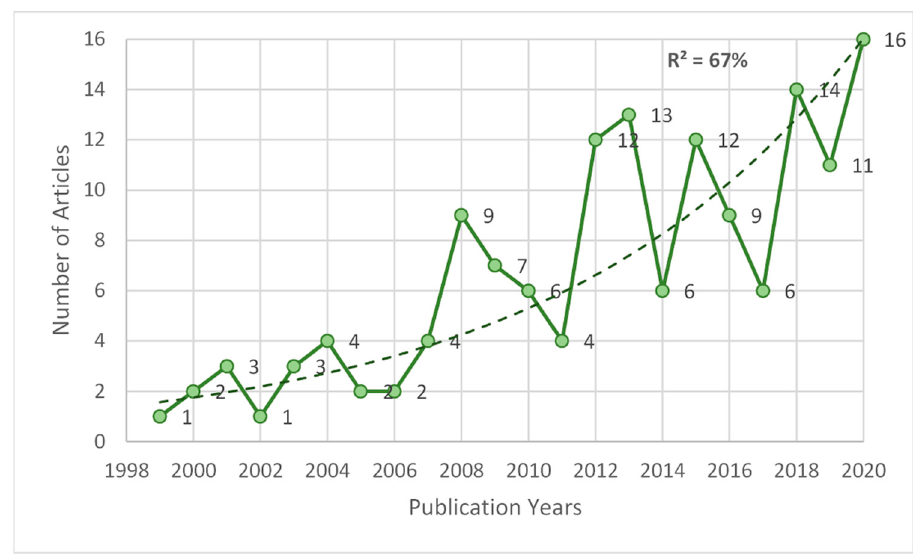
Figure 1. Temporary trend of publications on coffee/caffeine and sport (1999–2020).